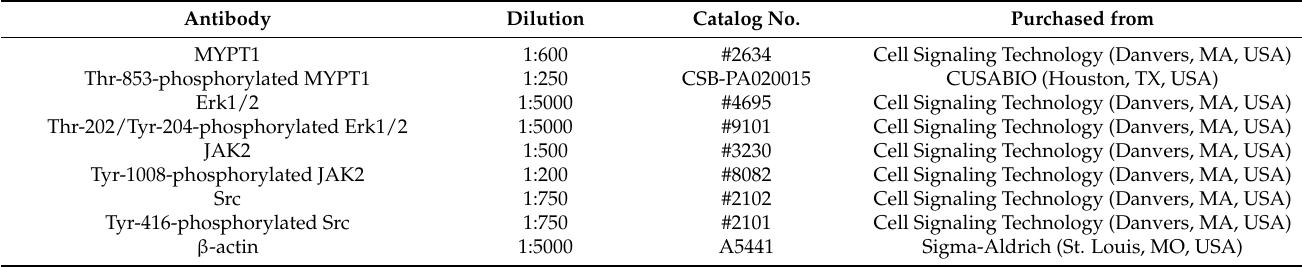
Table 2. Primary antibodies used in this